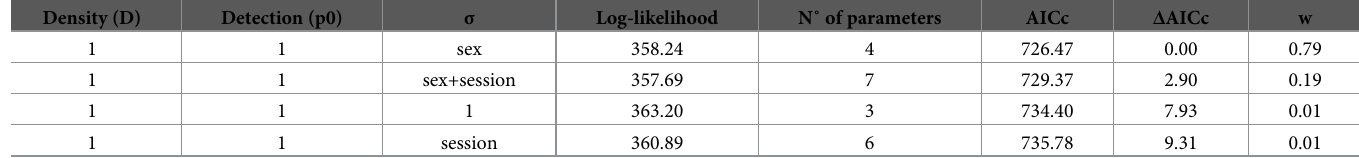
Table 2. Candidate set models evaluating the role of covariates on the spatial scale ( σ ) of the margay (AICc: Akaike Information Criteria for small sample sizes; Δ AICc: Difference between AICc of each model and the model with the lowest AICc; w: Weight). Density (D)